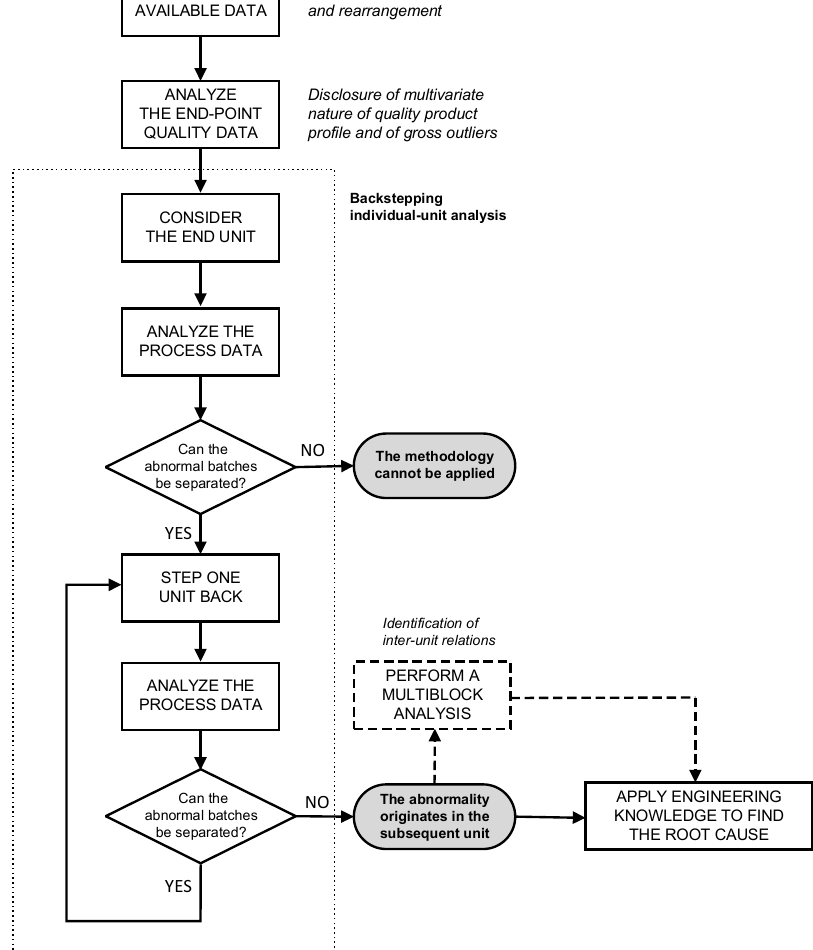
Figure 2. Schematic of the proposed backstepping methodology to support the troubleshooting of plant-wide batch